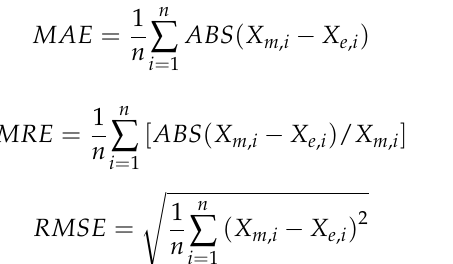
Figure 7. The gravity anomaly map in the Qinling mountain area.